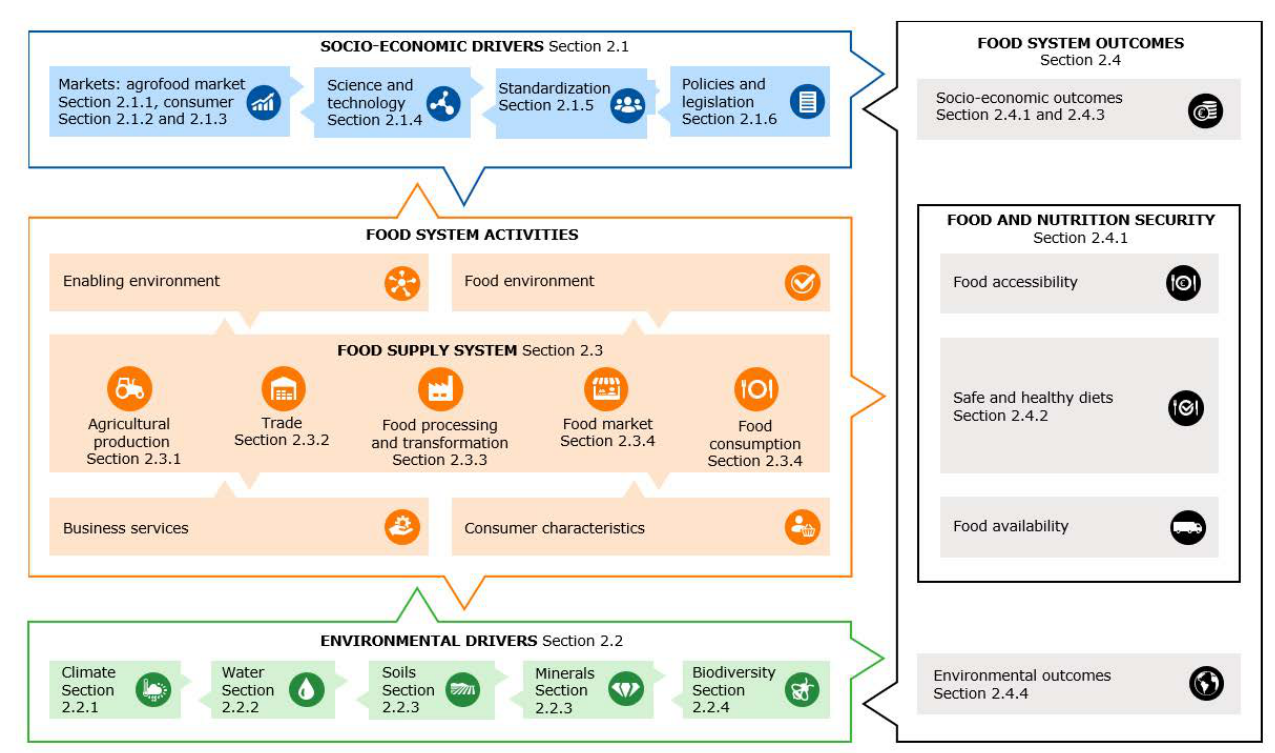
Figure 1. Food system analysis of the bread food value chain in sub-Saharan Africa, modified with permission based on [3]. The paragraph numbers included refer to the sections in this